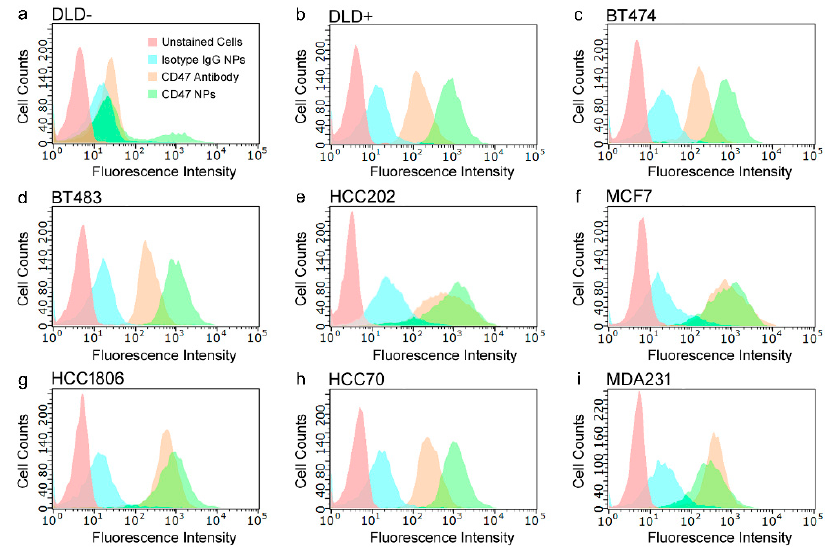
Figure 3. FACS plots showing the fluorescence intensity associated with each cell line tested including: ( a ) DLD − ; ( b ) DLD+; ( c ) BT474; ( d ) BT483; ( e ) HCC202; ( f ) MCF7; ( g ) HCC1806, ( h ) HCC70; and ( i ) MDA231. The following experimental groups were tested within each of the cell lines (1) Unstained cells ( red ), (2) cells incubated with IgG SERS NPs ( blue ), (3) cells incubated with CD47 antibody ( orange ), and (4) cells incubated with CD47 SERS NPs ( green ). FACS was used to assess which cell lines demonstrated significant binding with our CD47 SERS NPs.